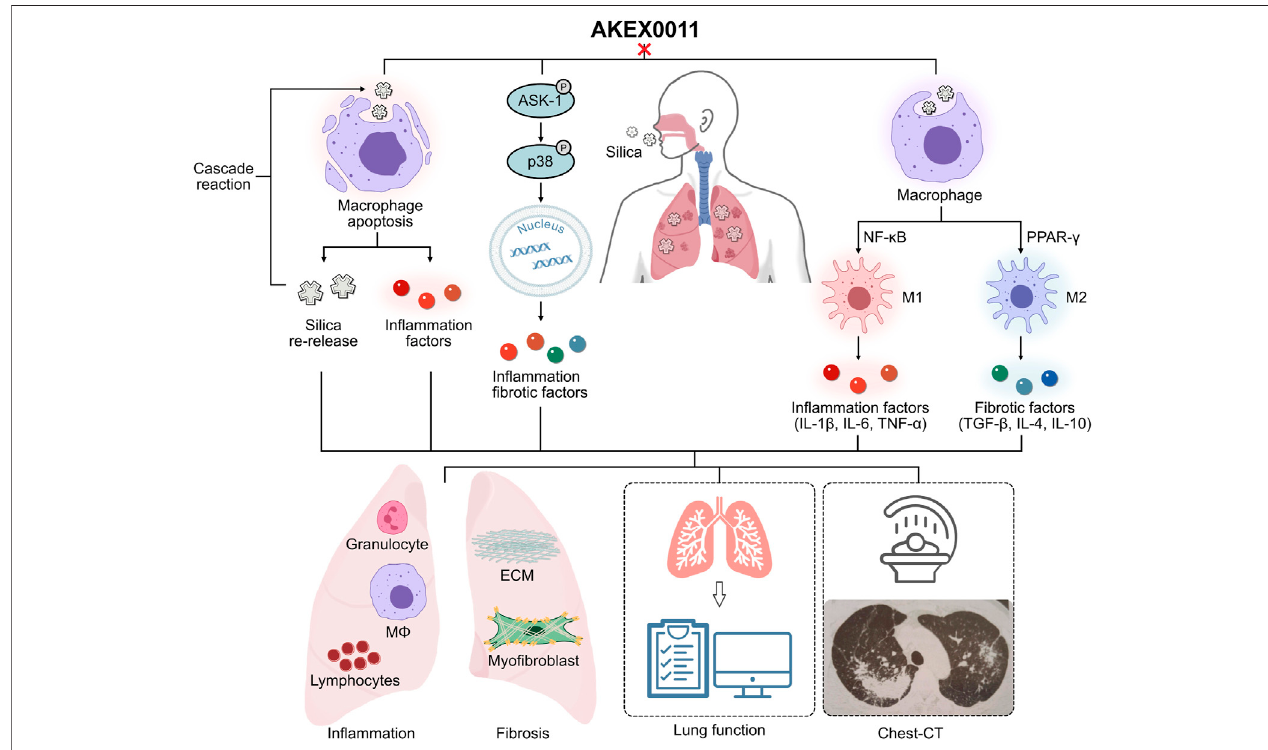
FIGURE 10 | Ideograph of AKEX0011 ’ s therapeutic effects. AKEX0011 alleviated the in fl ammatory and fi brotic reactions of silicosis through the following mechanisms (A) Apoptosis: AKEX0011 reduced silica-induced apoptosis and alleviated the in fl ammatory cascade caused by apoptosis, which ultimately reduced the extent of silicosis. (B) ASK1-p38 MAPK signaling pathway: silica can induce in fl ammation and fi brosis by activation of the ASK1-p38 MAPK signaling pathway. AKEX0011amelioratedin fl ammationand fi brosisbyinhibitionoftheactivationofthep38signalingpathway. (C) Macrophagepolarization:Inthepathophysiologyof silicosis, the macrophage polarization disorder occupies an important position. AKEX0011 reduced macrophage polarization through suppressing NF- κ B and PPAR- γ